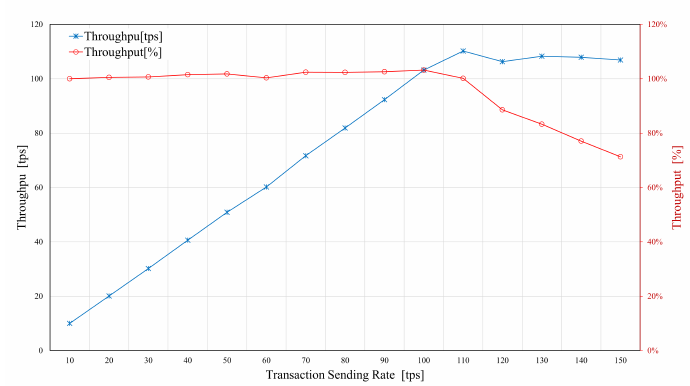
Figure 12. Throughput vs. transaction sending rate.